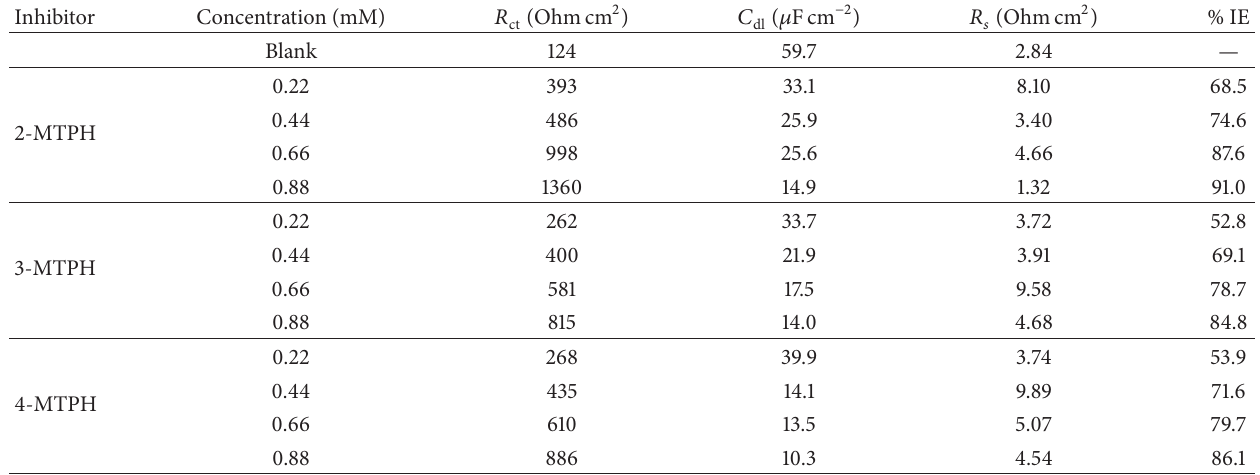
Figure 8: Equivalent circuit model. Table 6: Impedance parameters for the corrosion of MS in 0.5 M HCl in the absence and presence of different concentrations of inhibitors at 303